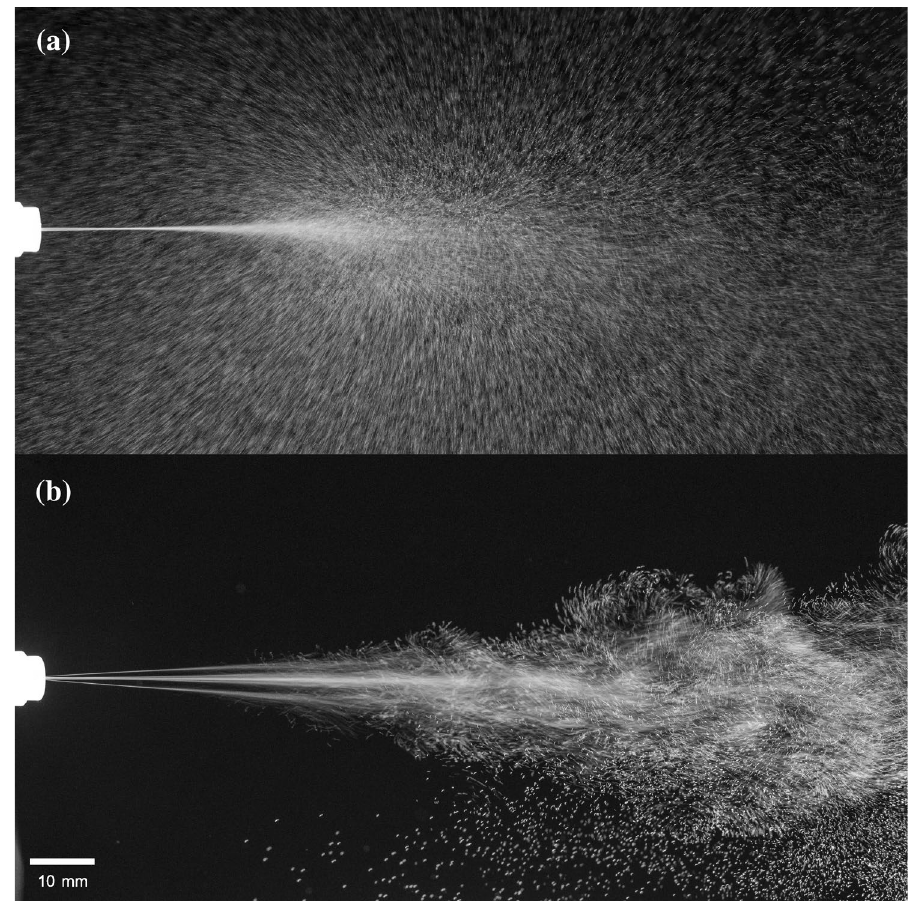
Figure 1. Typical spray plumes with and without self-charging. ( a ) The spray plume generated by a nozzle with 2 µ m using demineralized water. Due to the small spacing between jets, the individual jets 8 holes of radius R = cannot be discriminated and appear as one single jet. The self-charging makes the spray plume flare out once the droplets have decelerated significantly. Because of a decrease in coalescence, spray droplets are significantly smaller with self-charging, reducing the maximum travelled distance of the spray plume. ( b ) The same spray now containing small amounts of salt. As there is no charging the spray plume remains narrow and travels a longer distance. Still, due to vortices and complex flow in the surrounding air the spray plume starts to diverge and mix as